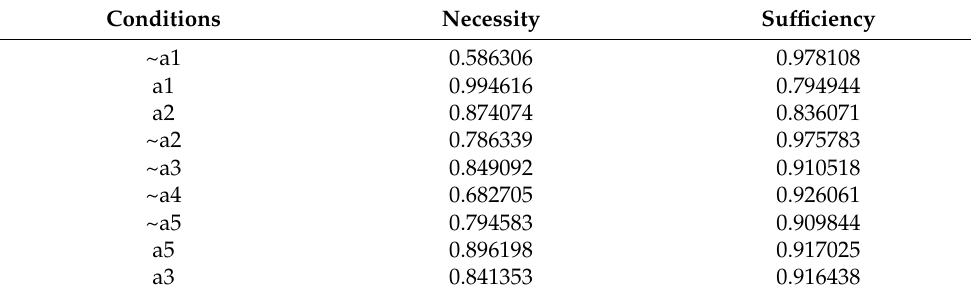
Table A5. Necessity and sufficiency analysis of conditions (outcome ~A1).